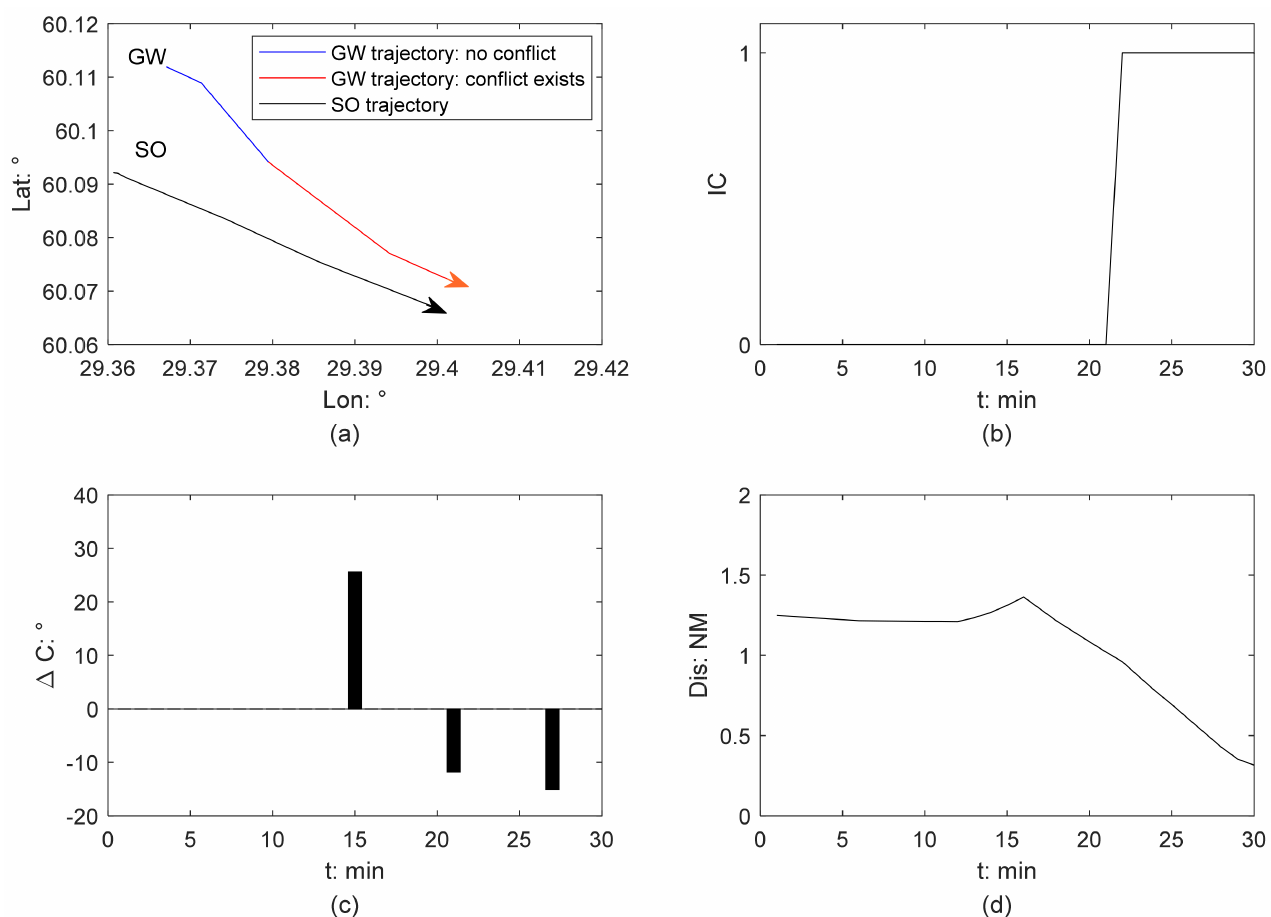
Figure 3. Ship collision detection from GW perspective in Scenario 1: ( a ) ship trajectory; ( b ) ship collision risk identification; ( c ) course change of a GW; ( d ) relative distance between this ship pair.